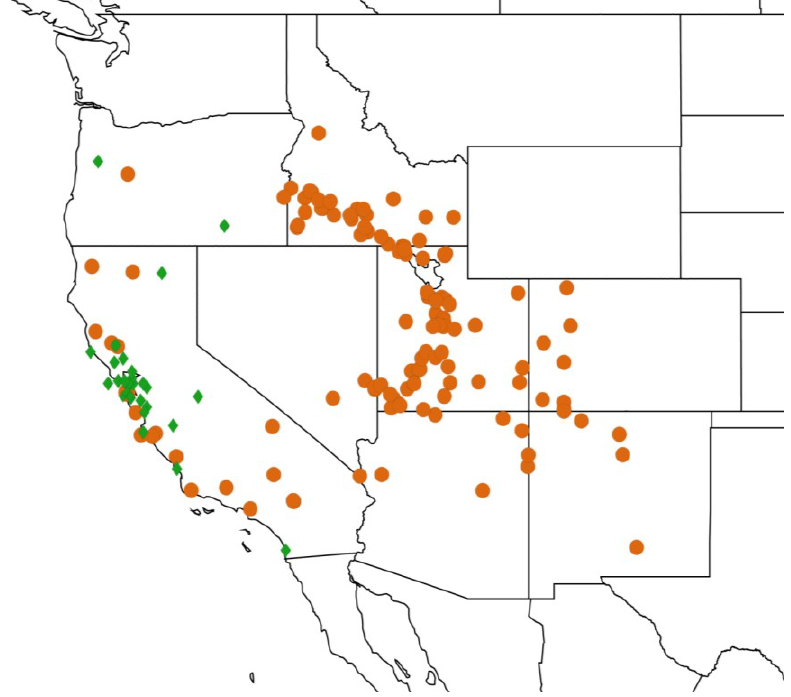
Figure 43. Distribution of Neoplatypedia ampliata (green diamonds) and N. constricta (orange